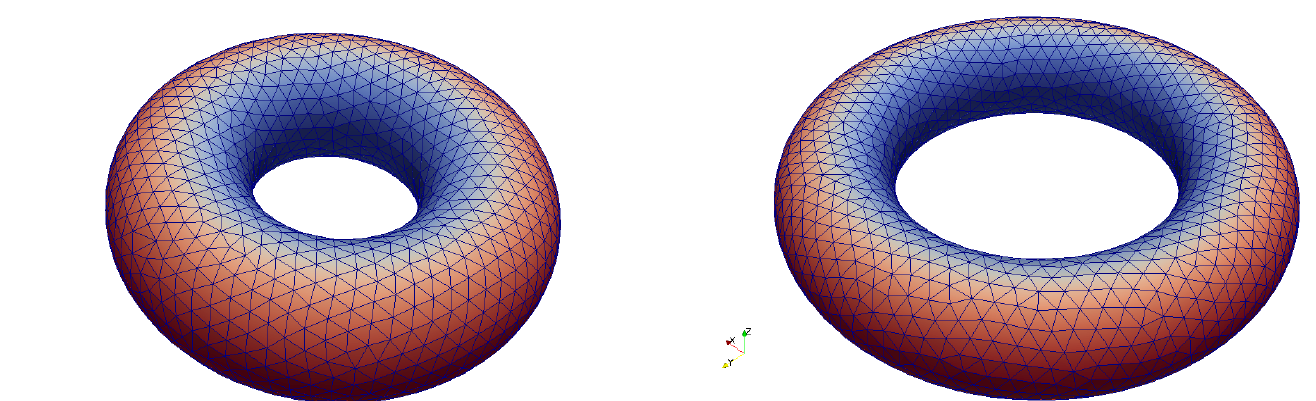
Figure 1. Initial “fat” R = 0.66 and r = 0.30 torus mesh used for most calculations ( left ) and alternative “thin” R = 0.84 and r = 0.24 mesh just for validation experiment ( right —see text). Indicative colouring corresponds to MVP values.